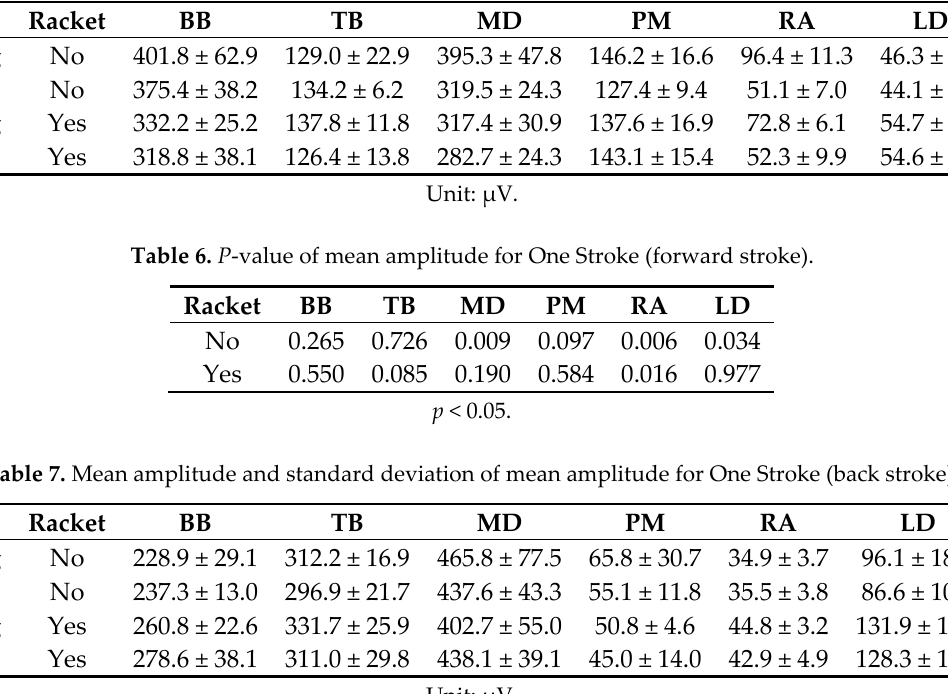
Table 5. Mean amplitude and standard deviation of mean amplitude for One Stroke ( forward stroke ) .